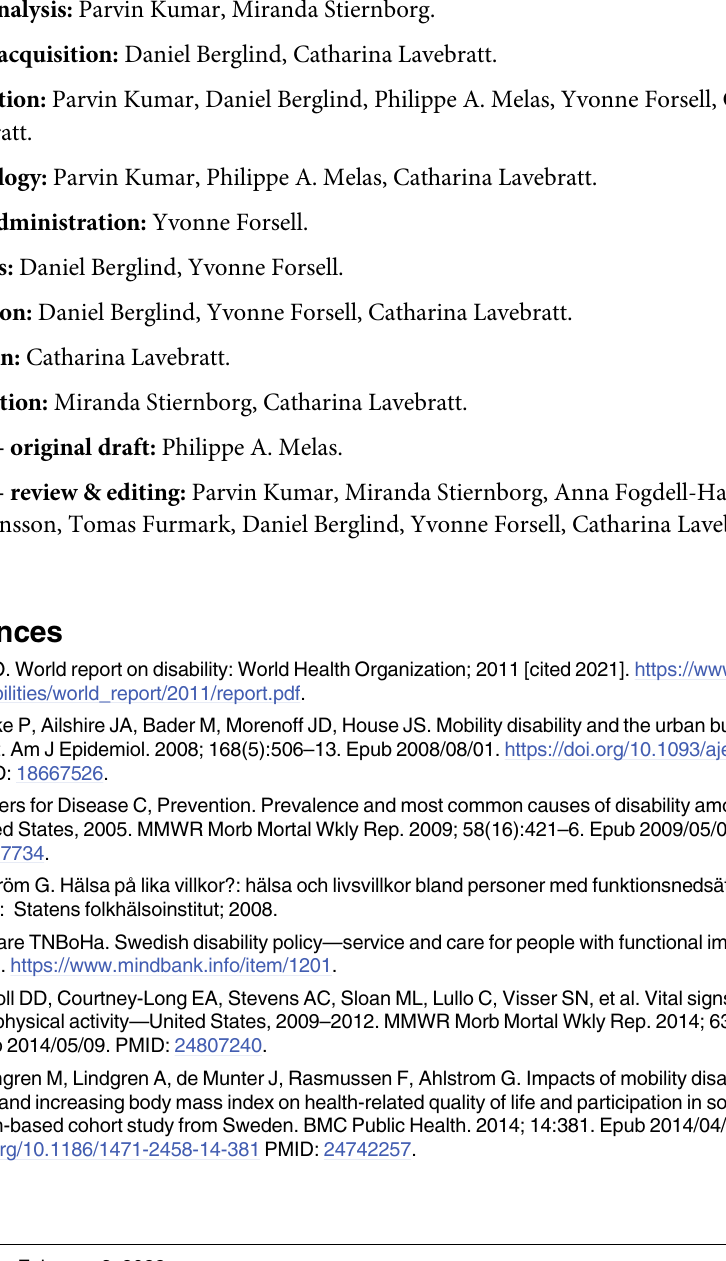
S2 Table. Baseline characteristics of the study participants with mobility disability (N = 38) and comparisons with those MD individuals who contributed blood but were not included in this study (N = 50). S3 Table. Lower Level Of Detection (LLOD) values for all measured